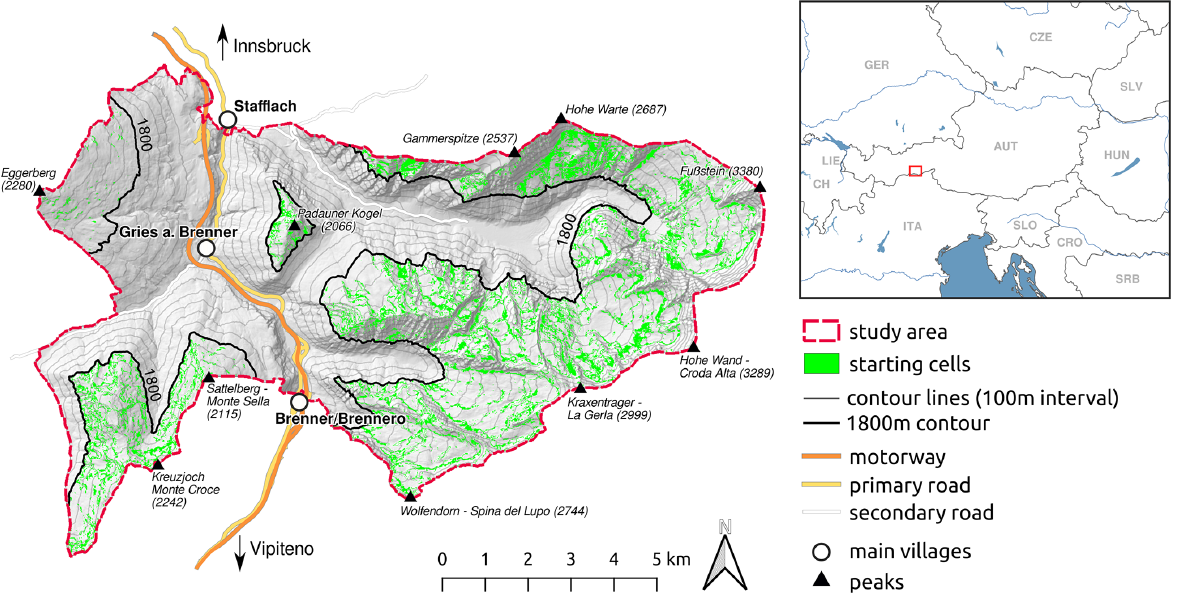
Figure 7. Study area for Flow-Py performance testing on a regional scale. Snow avalanche starting cells (green) are defined by locations above 1800m on slope inclinations between 31 and 34 ◦ . The maps utilize datasets from the following sources. (a) ©OpenStreetMap contributors 2021. Distributed under the Open Data Commons Open Database License (ODbL) v1.0. (b) Natural Earth. Free vector and raster map data at https://www.naturalearthdata.com/ (last access: 1 October 2021). (c) Land Tirol – https://www.tirol.gv.at/statistik-budget/tiris/ (last access: